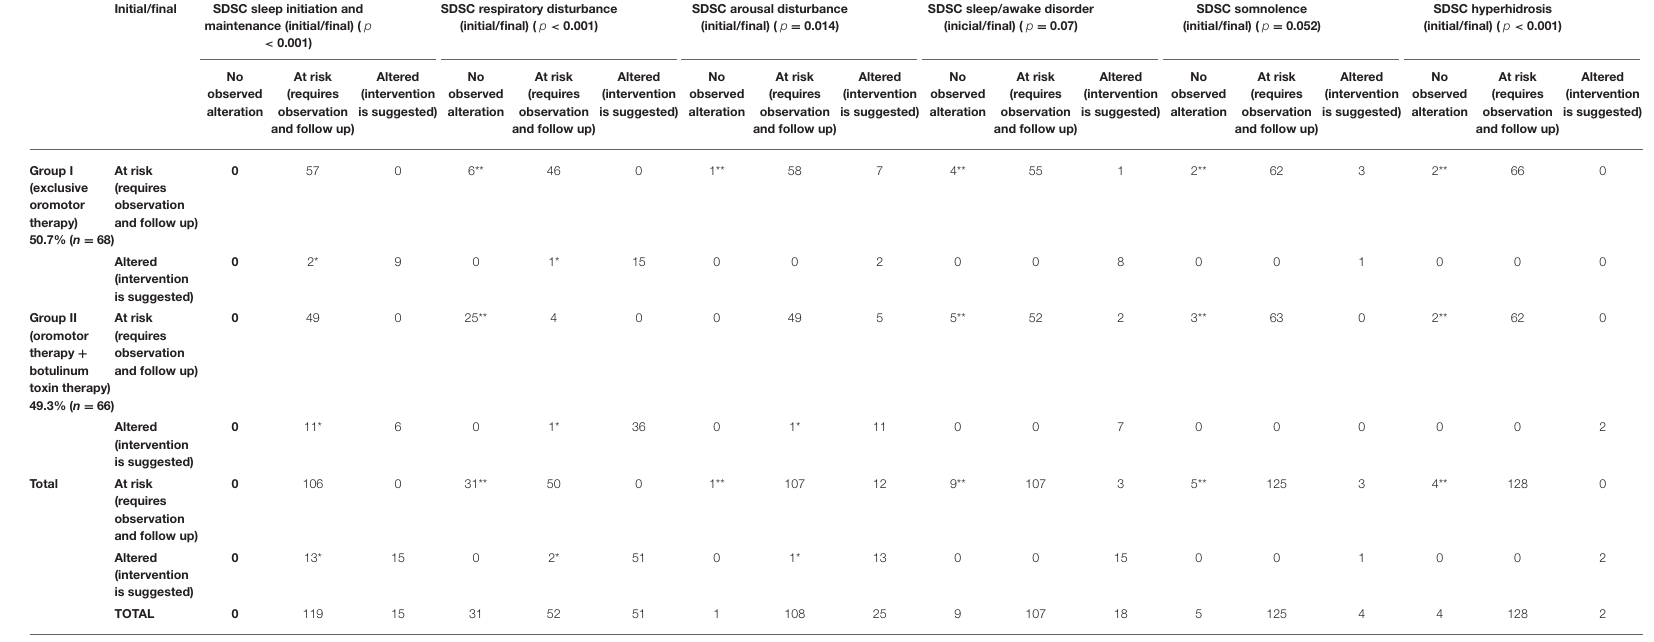
TABLE 4 | Relation between treatment groups in the initial and final Sleep Disorders Subscales